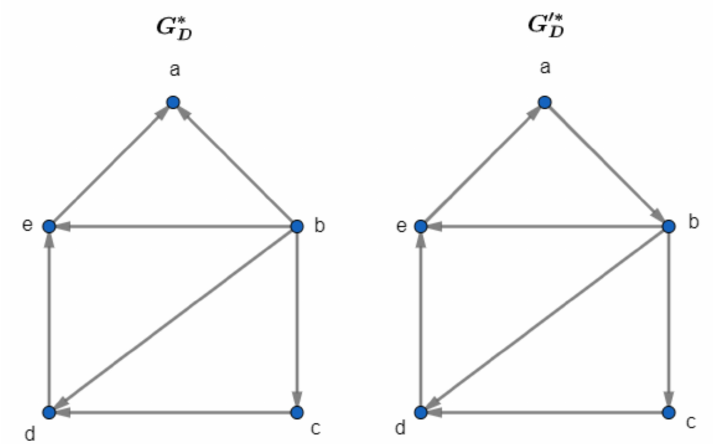
Figure 6. G ∗ and G ∗ are the latent digraphs of G D and G D (cid:48) , respectively. D D (cid:48)